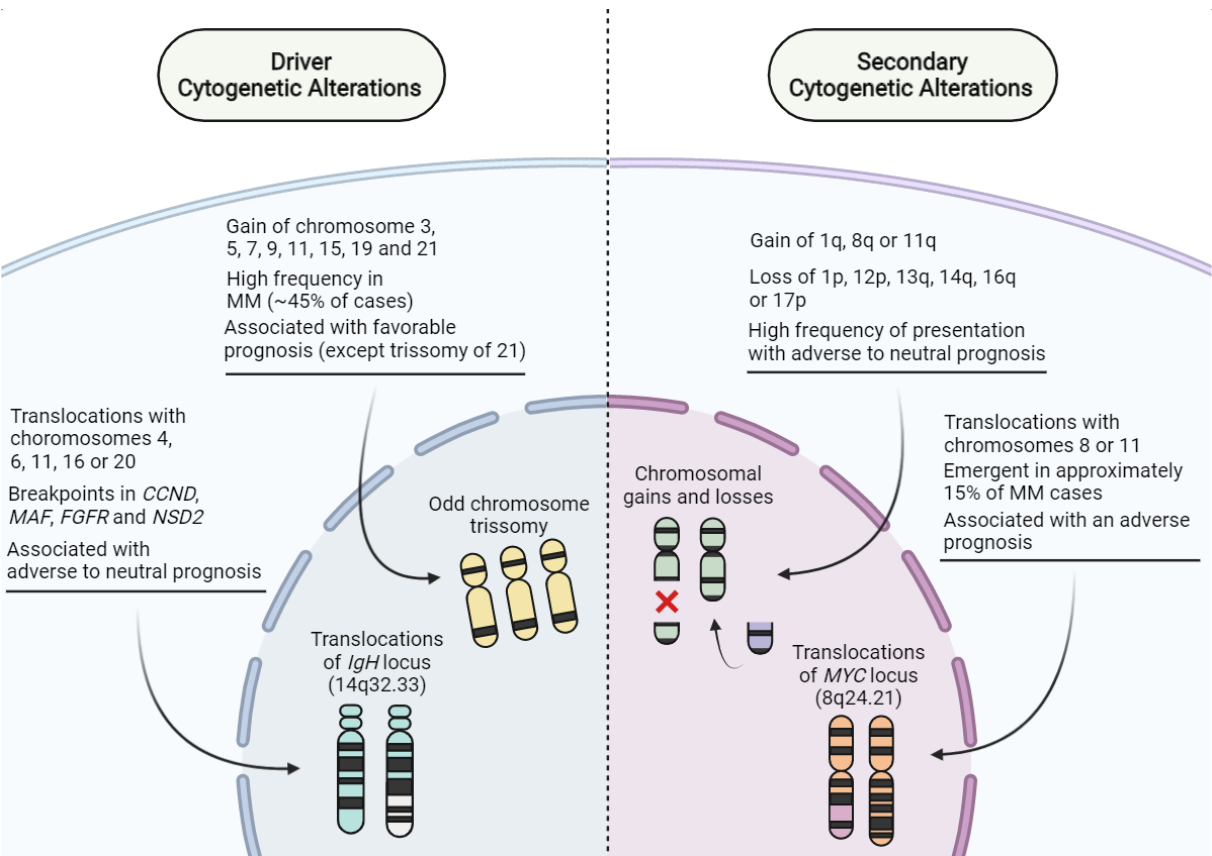
Figure 1. Cytogenetic alterations associated with multiple myeloma (MM). In pre-malignant settings, driver alterations correlate with deregulation of oncogene activity and carcinogenesis onset. At later disease stages, secondary alterations emerge due to genomic instability in malignant clones, and MM cells from the same patient may even harbor different secondary alterations, following the concepts of linear and branching evolution. Created with BioRender.com.